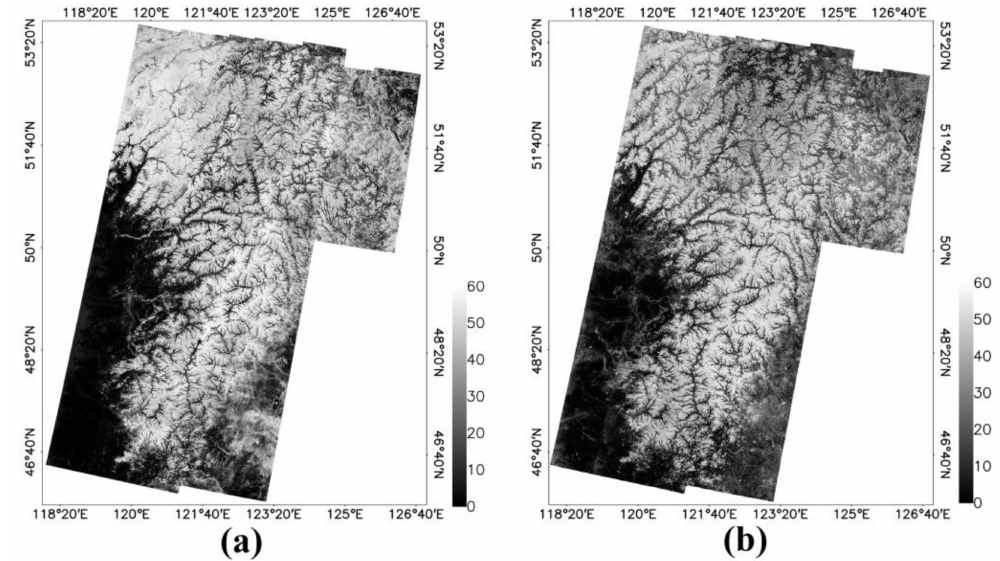
Figure 11. Maps of forest canopy coverage produced by di ff erent indirect estimation models: ( a ) model_2015 and ( b ) model_2018.